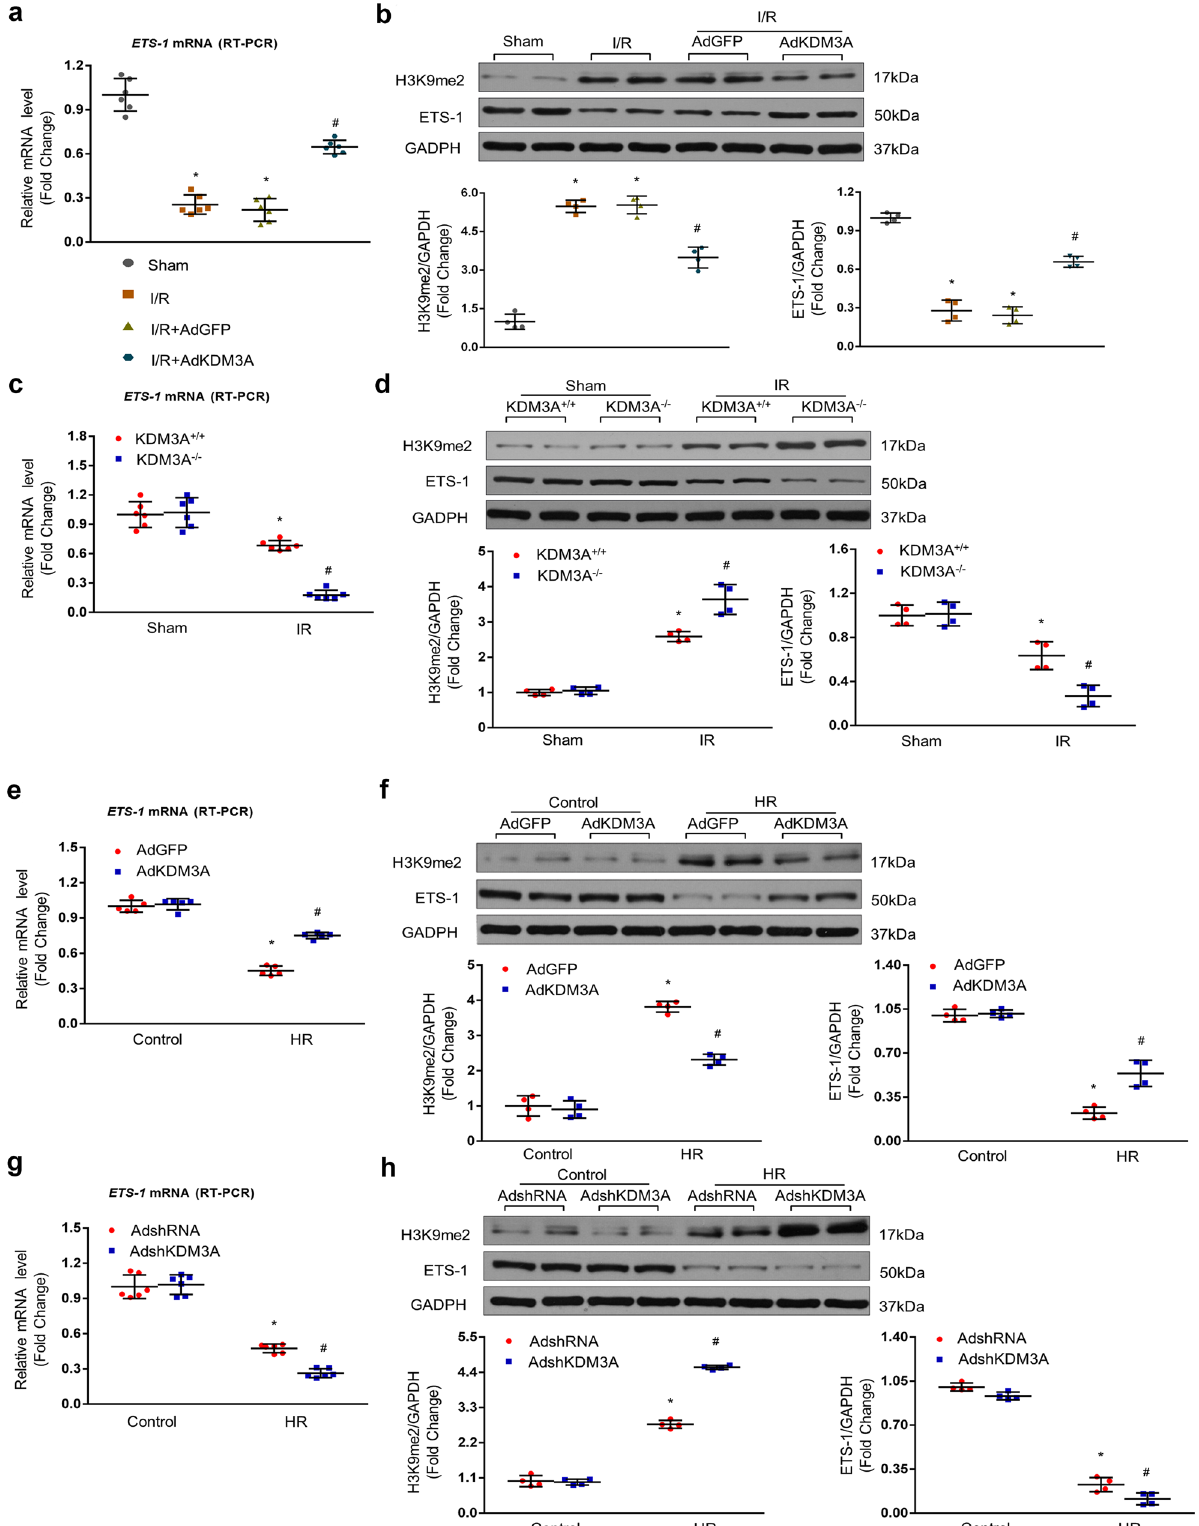
However, the exact impacts and potential mechanisms of KDM3A in cardiac insult, especially for MIRI are less exploited. Recently, Mathias and coworkers revealed that KDM3A is upre- gulated in maladaptive cardiac remodeling, and KDM3A corre- lates positively with increased ANP and BNP expression and inversely with H3K9me2 in the promoter region of ANP 26